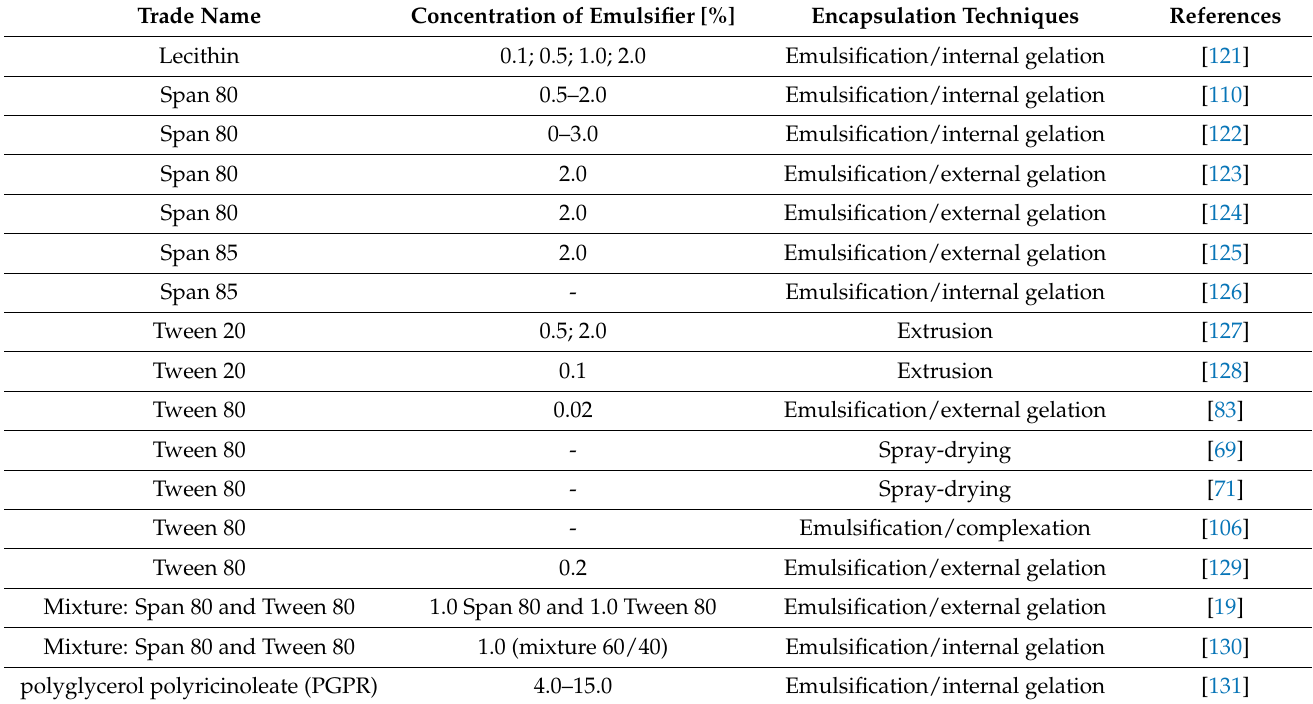
Table 2. Surfactants used in the production of alginate